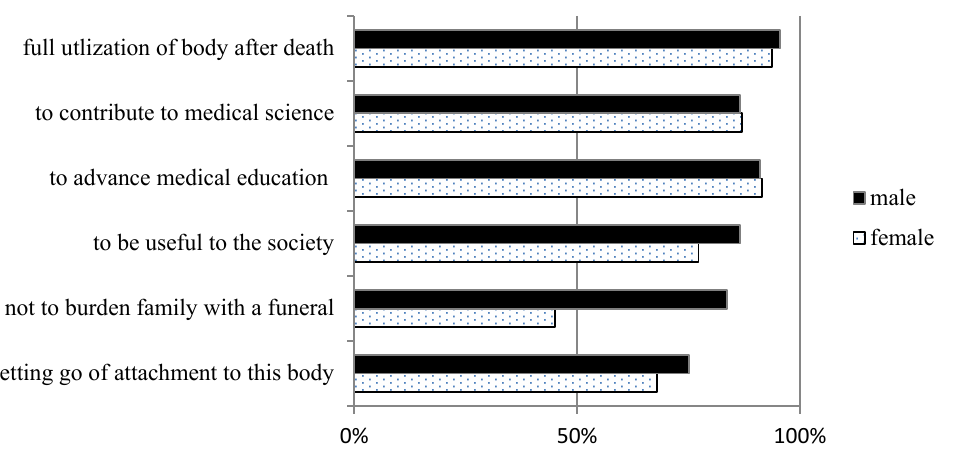
Figure 1. Reasons for body donation among male and female registered donors. Total number of respondents = 336.